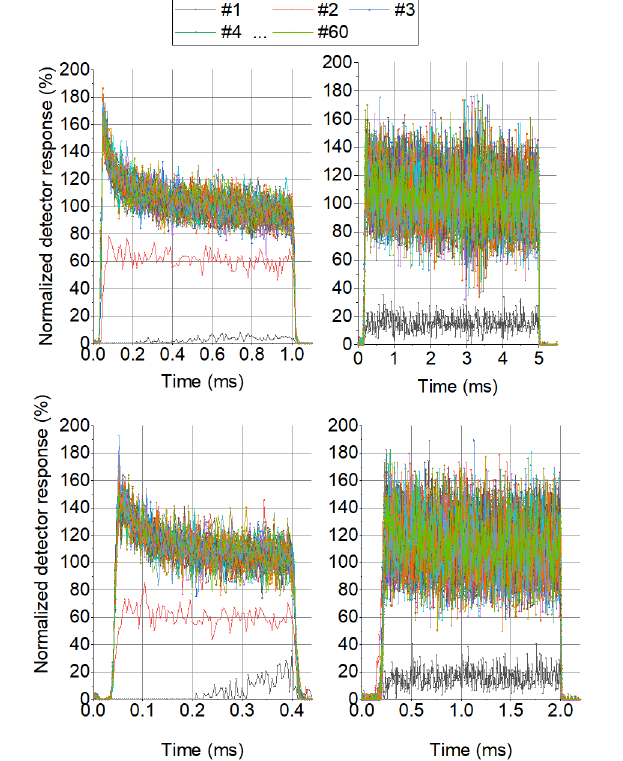
Fig. 8 Cadmium-covered detector response to P-385 D-D neutron generator operated in pulsed mode. Counts integrated per 5 s for 5 minutes of operation at 130 kV @70 µA (i.e. 60 batches denoted as #1 to #60. For 100 Hz, 1 batch sums over 500 cycles, for 250 Hz one batch sums over 1250 cycles). Top left: 100 Hz, DF 10%. Top right: 100 Hz, DF 50%. Bottom left: 250 Hz, DF 10%. Bottom right: 250 Hz, DF 50%.